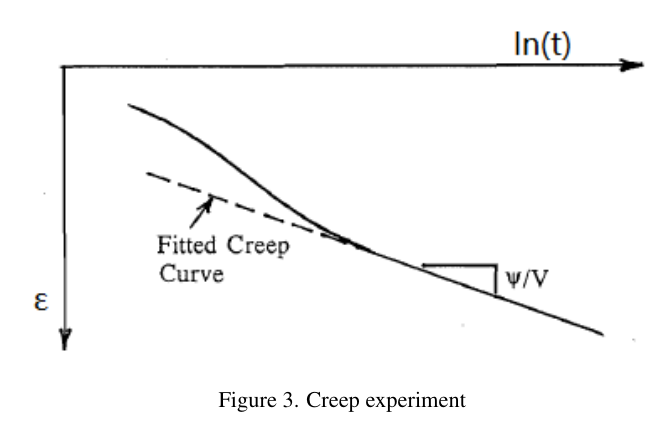
Figure 3. Creep experiment